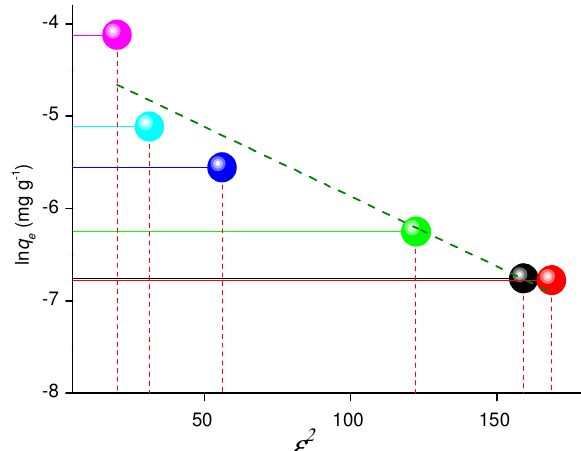
Fig. 11: Dubinin- Radushkevich (D-R) Adsorption Isotherm (Adsorbent Dose 0.5 g per 50 ml, pH 6, Shaking Time 2hrs, Temp: 25 ± 2 O C, at various initial As (III) Concentrations with Shikarap Iron Ore) Above 9-16 kJ/mol is termed as chemical adsorption.